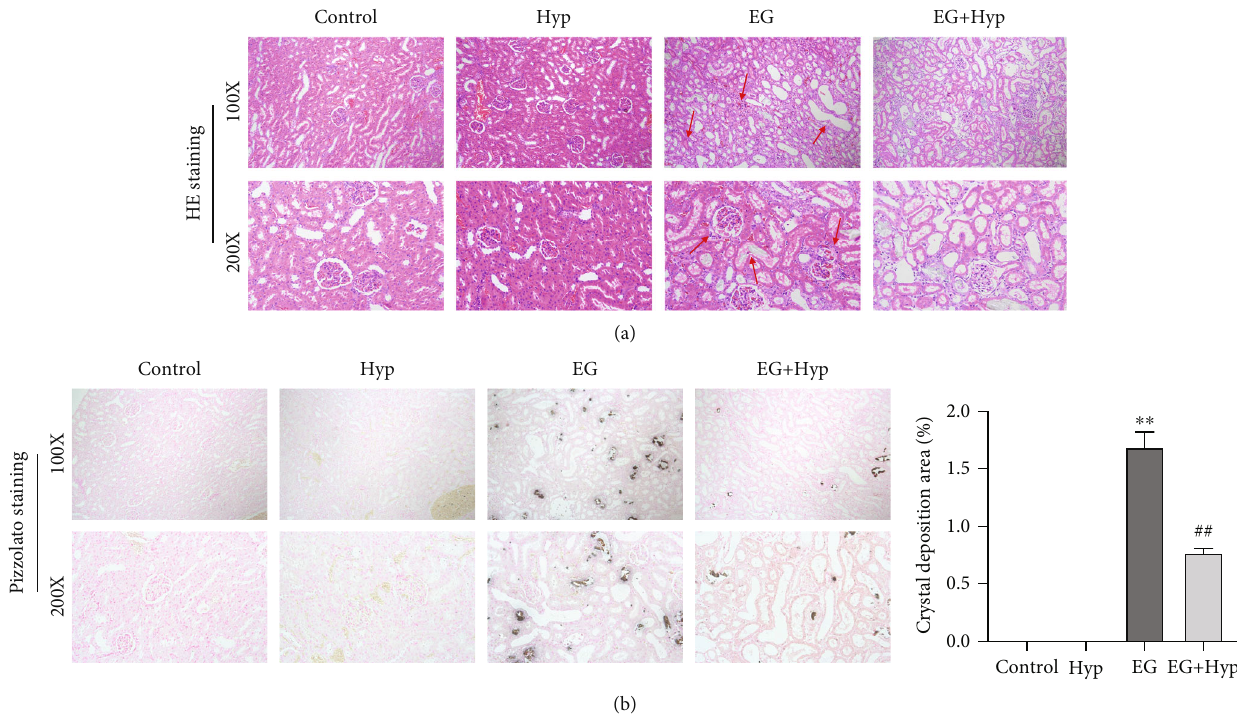
Figure 1: E ff ect of hyperoside on ethylene glycol-induced histopathological damage and calcium oxalate crystal deposition in rat kidney. (a) HE staining was used to observe the pathological damage of renal tissues; (b) Pizzolato staining was employed to assess the deposition of calcium oxalate crystals in renal tissues of rats, with black crystals representing calcium oxalate crystal deposition, ∗∗ P < 0 : 01 vs. control group and ## P < 0 : 01 vs. EG group.